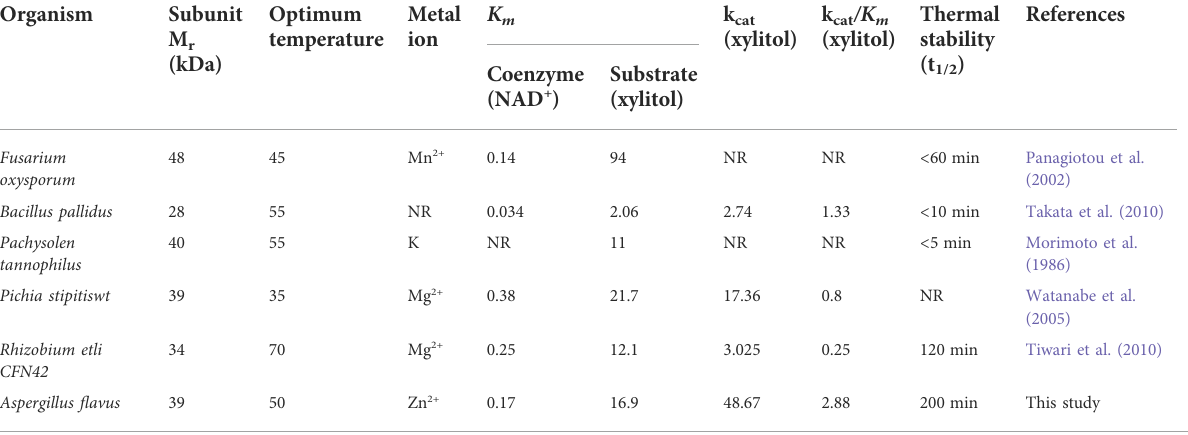
TABLE 2 Biochemical and kinetic properties of xylitol dehydrogenases from various organisms.